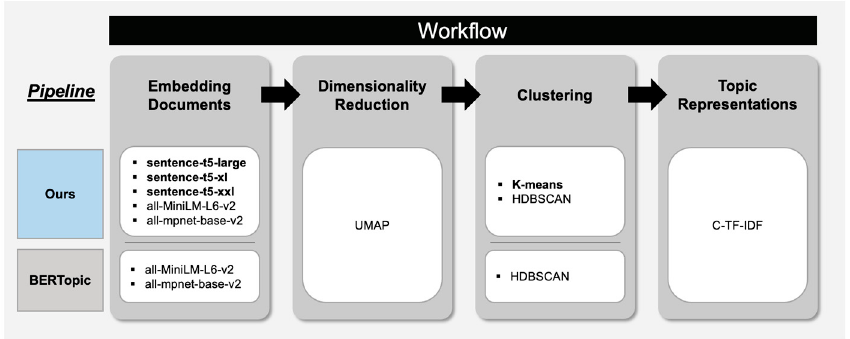
Figure 2. Workflow of our approach. Our approach shares the same pipeline with BERTopic. However, our approach has more options for choosing the models.